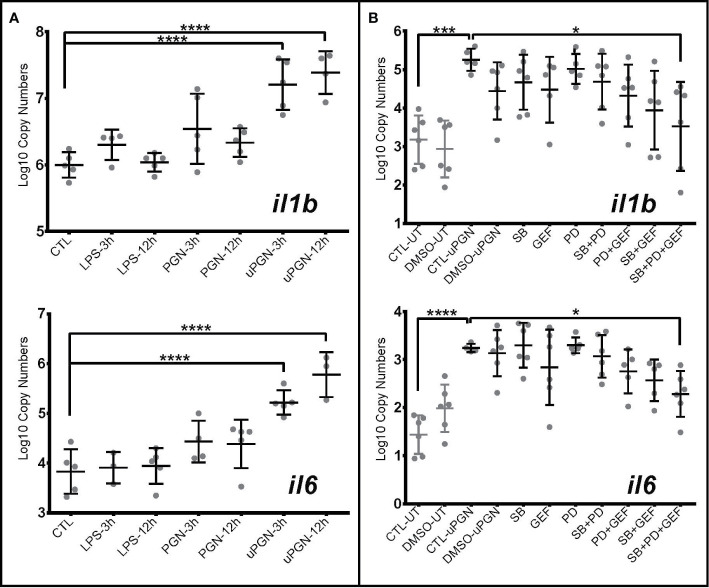
Ultra-pure peptidoglycan (uPGN) triggers the strongest antibacterial response in Atlantic cod macrophages, mediated by NOD1 and MAPKs (A, B). Copy number (log10) of interleukin il6 and il1b in response to (A) an activation by various individual MAMPS during 3 and 12 h and (B) inhibition of nucleotide-binding oligomerization (NOD) pathway-relevant genes in uPGN-activated samples. PD, MEK1 and MEK2 Inhibitor; GEF, gefitinib; SB, p38 MAP Kinase Inhibitor. Whiskers show the standard deviation. Asterisks represent statistical significance: *<0.05, ***<0.001,**** <0.0001. Abbreviations: CTL, control; LPS, lipopolysaccharide; PGN, peptidoglycan; uPGN, Muramyl dipeptide peptidoglycan; UT, untreated; DMSO, dimethyl sulfoxide.